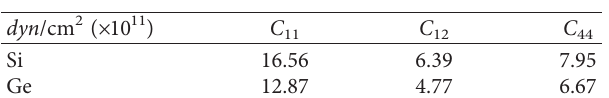
Table 1: Coefficient of elastic stiffness of IV semiconductor